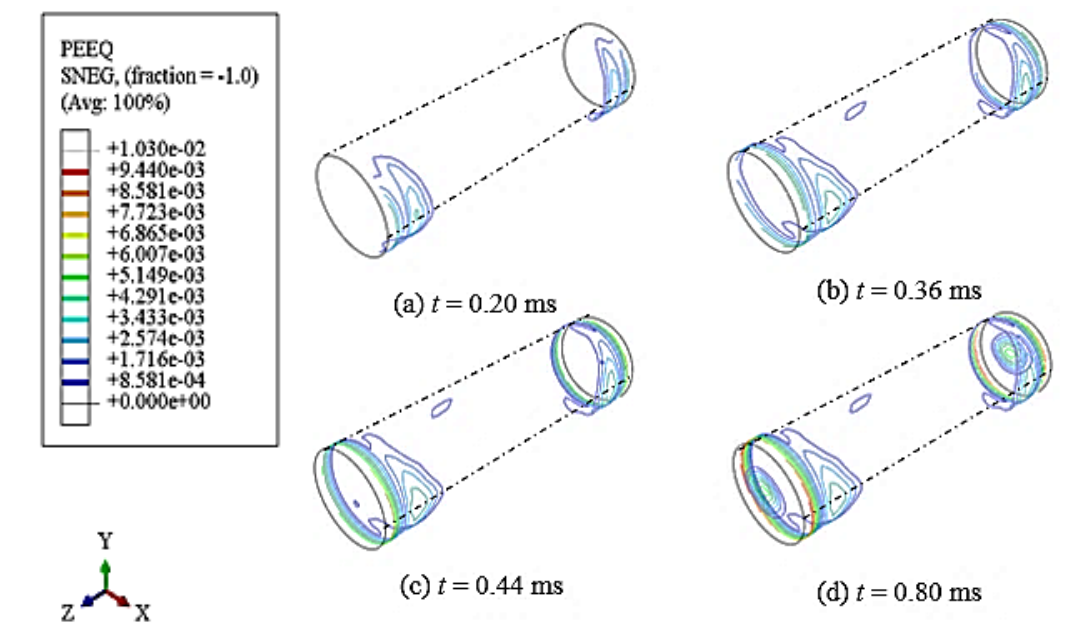
Figure 8. Isosurface diagram of cylindrical shell equivalent to plastic strain evolution process.